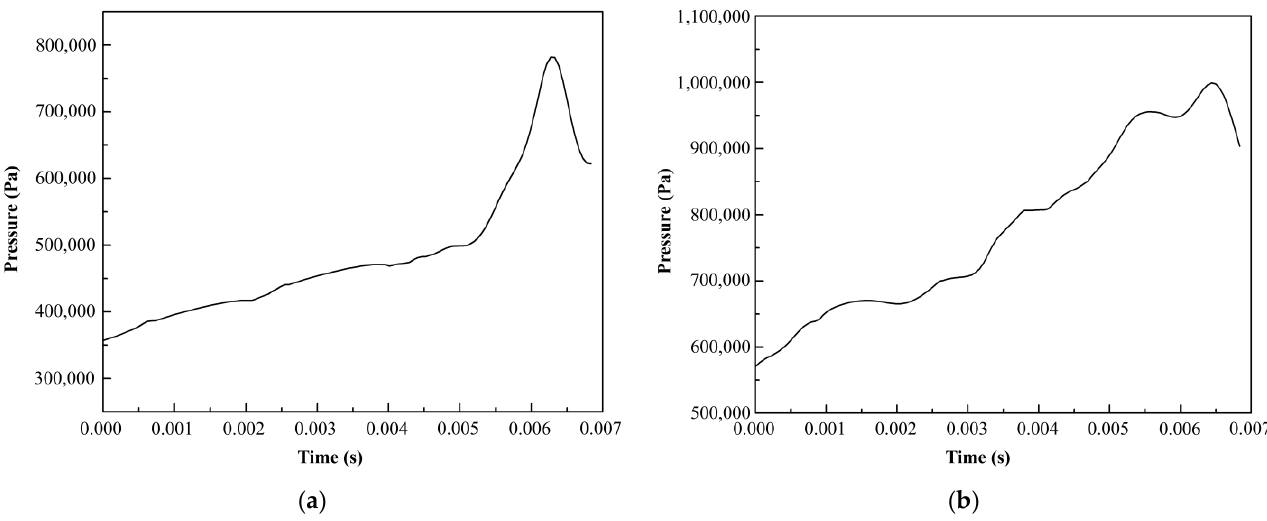
Figure 9. Pressure-time curves: ( a ) pressure-time curve of low-pressure stage; ( b ) pressure-time curve of high-pressure stage. Table 3. Results of CFD calculation.